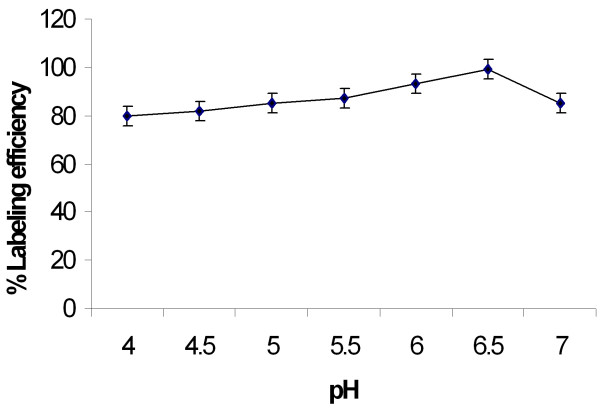
Effect of pH on the stability of 99mTc-noscapine. Results are the mean of three separate experiments